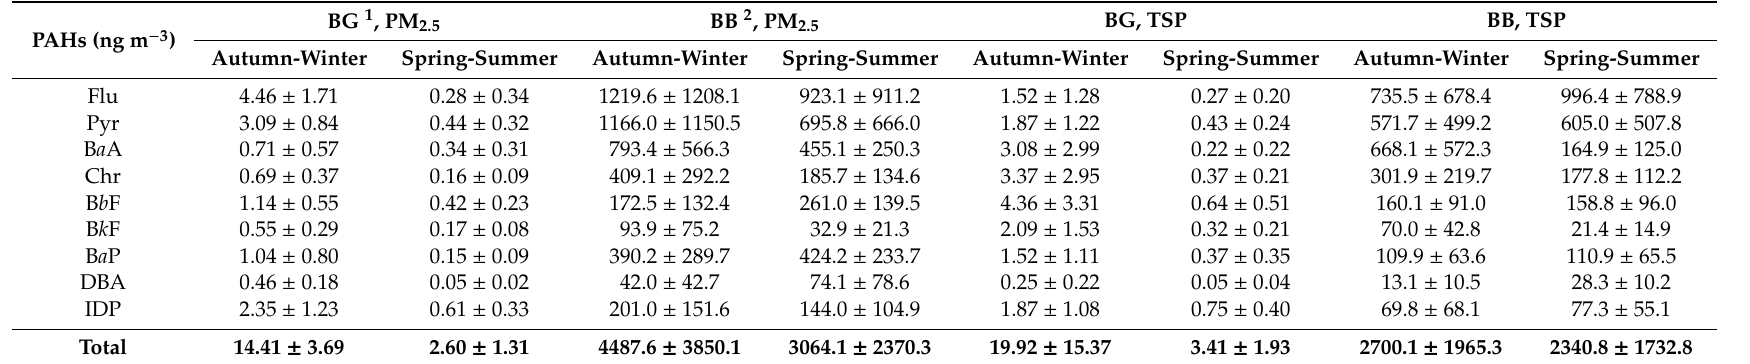
Table 1. Concentrations of PAHs in ng m − 3.